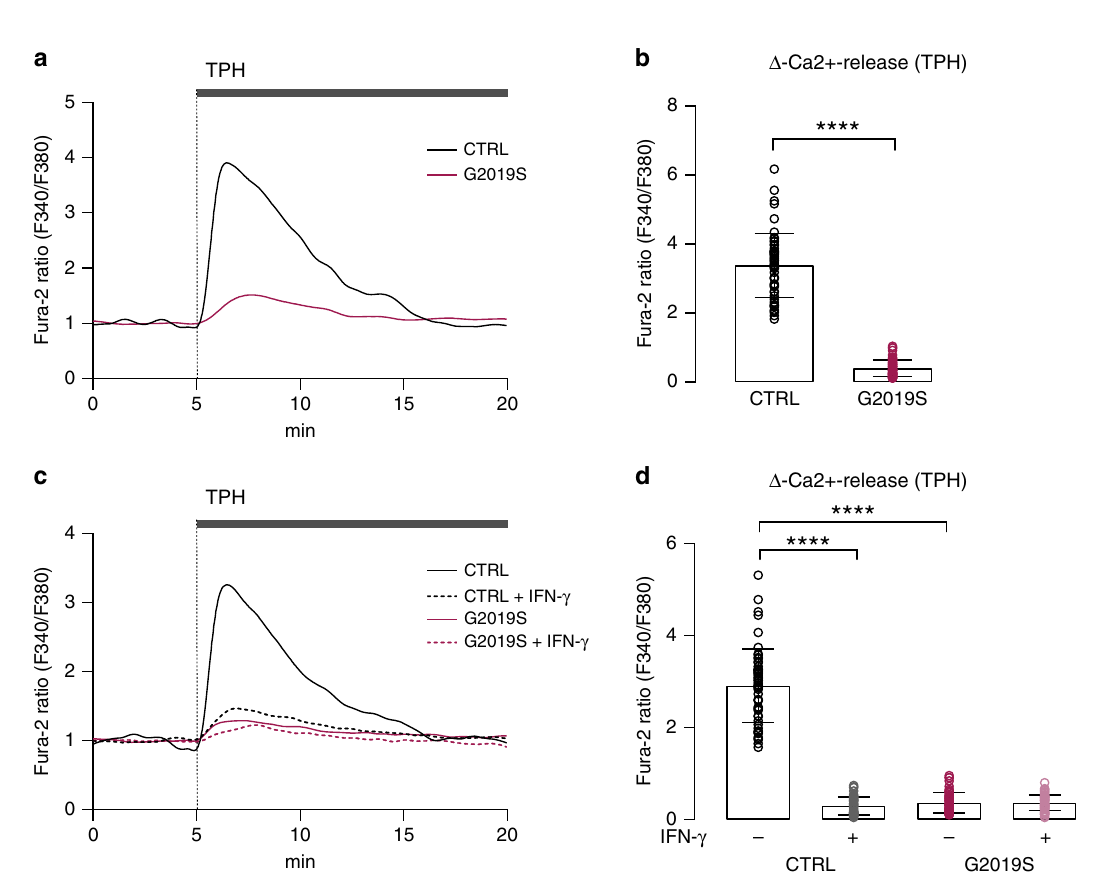
Fig. 3 LRRK2 G2019S alters Ca 2 + -storage and Ca 2 + response to IFN- γ . ER Ca 2 + release was measured after SERCA inhibition with thapsigargin (TPH, 500 nM) in human iPSC-derived neurons (G2019S and isogenic controls) using fura-2 AM ratiometric Ca 2 + imaging. a Individual Ca 2 + signaling traces of representative isogenic LRRK2 G2019S and control neurons are shown. The change in fl uorescence was normalized to the corresponding baseline fl uorescence prior to TPH stimulation. b Quanti fi cation of Ca 2 + peak amplitude ( Δ -Ca 2 + release) is shown (mean ± SEM, two-tailed t-test, **** P < 0.0001; n = 56 control and 59 G2019S individual cells examined over three independent experiments; non-normalized data are provided in the Data Source File). c Individual Ca 2 + signaling traces of representative isogenic LRRK2 G2019S and control neurons pretreated with 200 IU/mL IFN- γ for 24 h or left untreated. d Quanti fi cation of TPH-mediated Δ -Ca 2 + release is shown (mean ± SEM, two-way ANOVA, Bonferroni post hoc, **** P < 0.0001; n = 56 control, 42 IFN- γ treated control, 59 G2019S and 59 IFN- γ treated G2019S individual cells examined over three independent (Supplementary Fig. 3D). Interestingly, the rescuing effect of PTX These data suggest that LRRK2-associated changes in the was more pronounced in the LRRK2 G2019S cells. Indeed, the microtubule network are involved in NFAT shuttling. To validate ratio of luciferase expression in PTX-treated vs untreated these fi ndings in a more disease-relevant context, isogenic control ionomycin/PMA-stimulated cells was higher in G2019S cells than and LRRK2 G2019S neurons were treated with PTX and in to both non-transfected and wt LRRK2 -overexpressing cells immunostained for phospho-NFAT3, the cytosolic, inactive form (1.71 vs 1.30 and 1.45, respectively). of NFAT3. Basal levels of phospho-NFAT3 were signi fi cantly